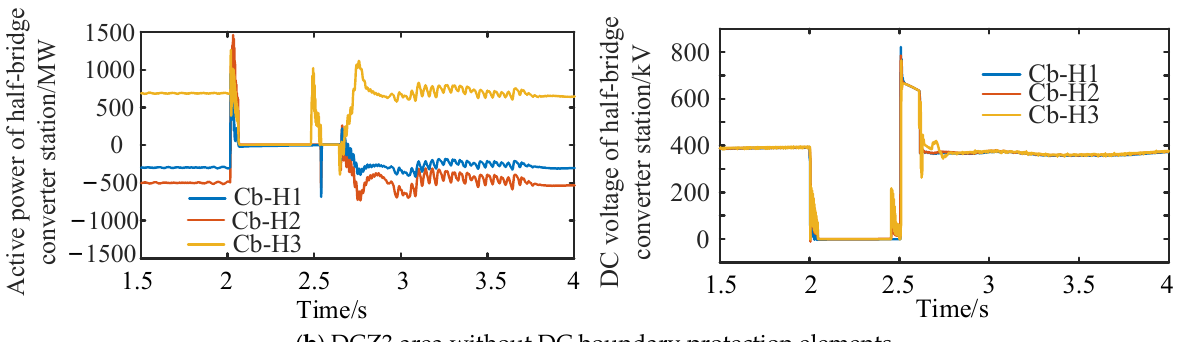
Figure 21. Simulation results of permanent short ‐ circuit fault of DC line in DCZ 3. According to the above simulation analysis, the internal converter of DCZ3 in the DC area has no fault self ‐ clearing ability and the AC circuit breaker needs to be opened during the process of fault DC area isolation. Therefore, it would take a long time for fault isola ‐ tion. The converter in DCZ3 is unlocked, and the fault DC area is reclosed after the AC circuit breaker is reclosed. Subsequently, the fault DC area is restarted, and it would take a relative long time. DCZ3 and DCZ2 are connected through DC/DC converter Cd ‐ E1, and